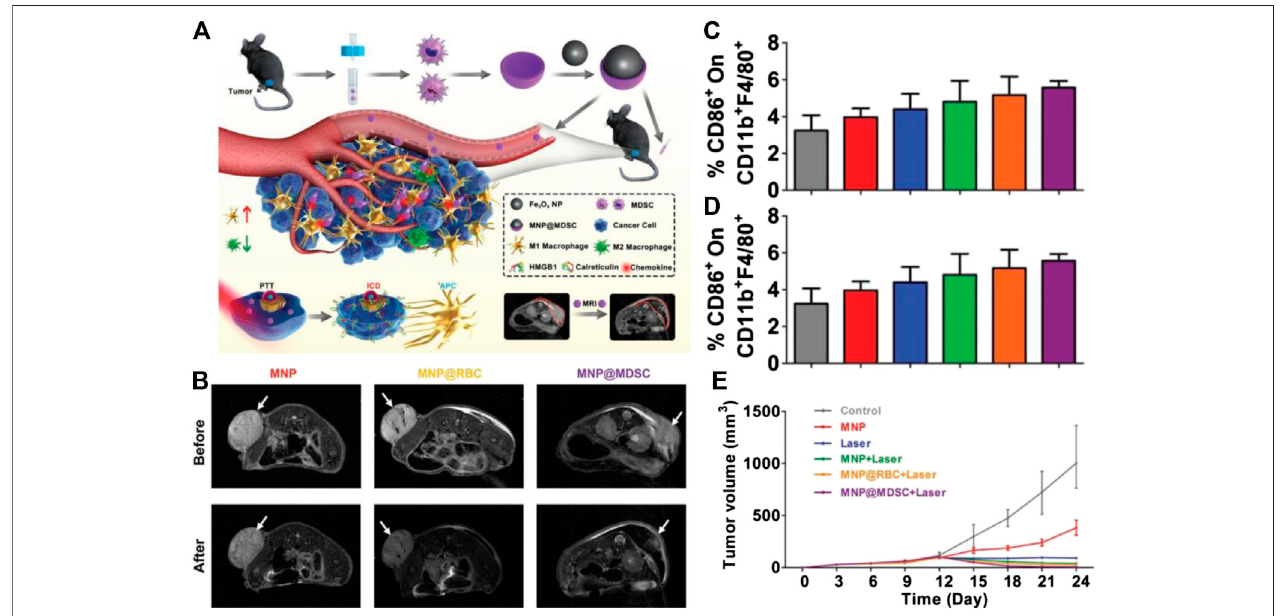
FIGURE 6 | (A) Schematic illustration of the synthesis of MNP@MDSC and its application in cancer theranostics (B) T 2 -weighted MR images of B16/F10-tumor- bearing mice taken before and after injection of the nanoparticles. (C) Percentage of CD86 + cells within the CD11 b + F4/80 + population of suspension cells from the mouse spleen after different treatments. (D) Percentage of CD206 + cells within the CD11b + F4/80 + population of suspension cells from the mouse spleen after different treatments. (E) Growth (in volume) curves of mouse tumors in different treatment groups. Reproduced with permission from Zhang F. et al. (2019). Copyright 2018 Wiley-VCH Verlag GmbH & Co.